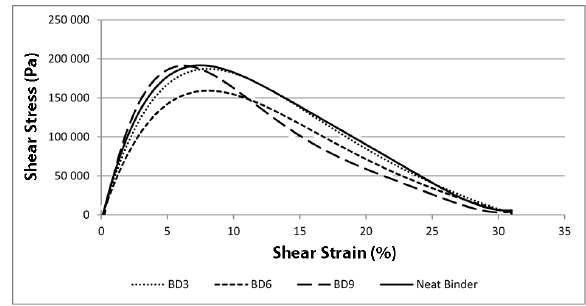
Fig. 6. Stress-Strain curves extracted from LAS testing of DSA modified binders Table 3. Values of shear stress for control and modified binders Sample Control Stress